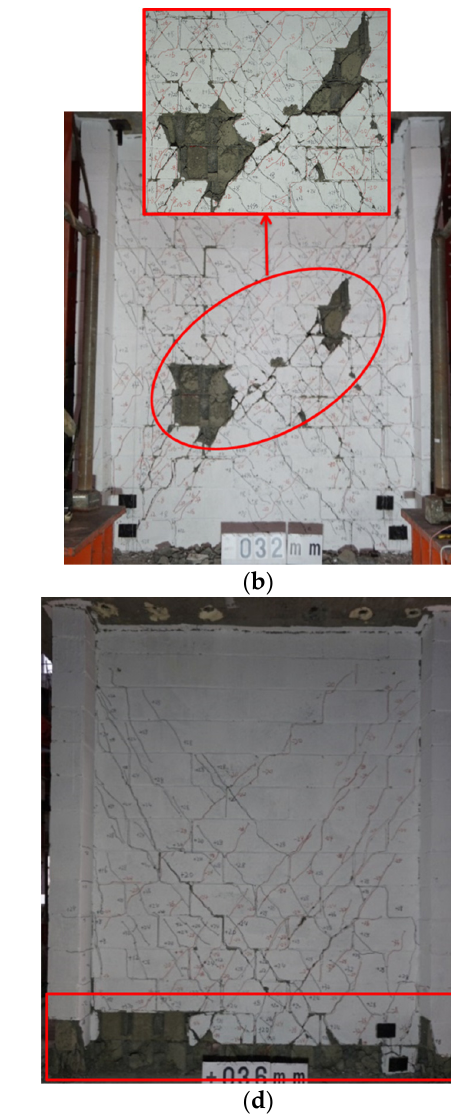
to the ends of the walls at approximately 45 degrees. Vertical cracks in both flanged end zones extending to the fourth course were also seen. During the loading cycle at 20 mm with a 0.71% drift top wall displacement, extensive diagonal cracks extended into wall toes and distributed on the entire wall. The crack width continued to increase. The wall lost about 18% of its capacity. The major diagonal crack gradually became distinct with a width of 6 mm at 24 mm with a 0.86% drift loading circle. Spalling of the face shells along the major diagonal crack at both segments occurred as the crack continued to widen. At the end of the test and at 32 mm with 1.14% drift loading cycle, vertical cracks at the flanged end zone and the major diagonal crack became wider. A significant face shell spalling in Appl. Sci. 2021 , 11 , x FOR PEER REVIEW these regions led to a loss of 38% of the wall capacity.